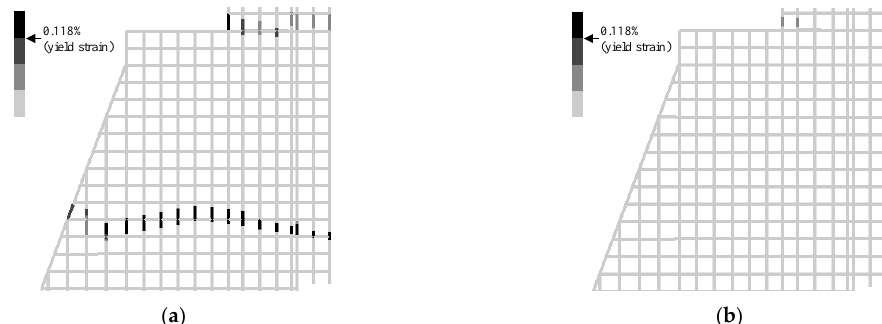
Figure 25. Maximum principal strain distribution of TYPE-A at 8.65 s.